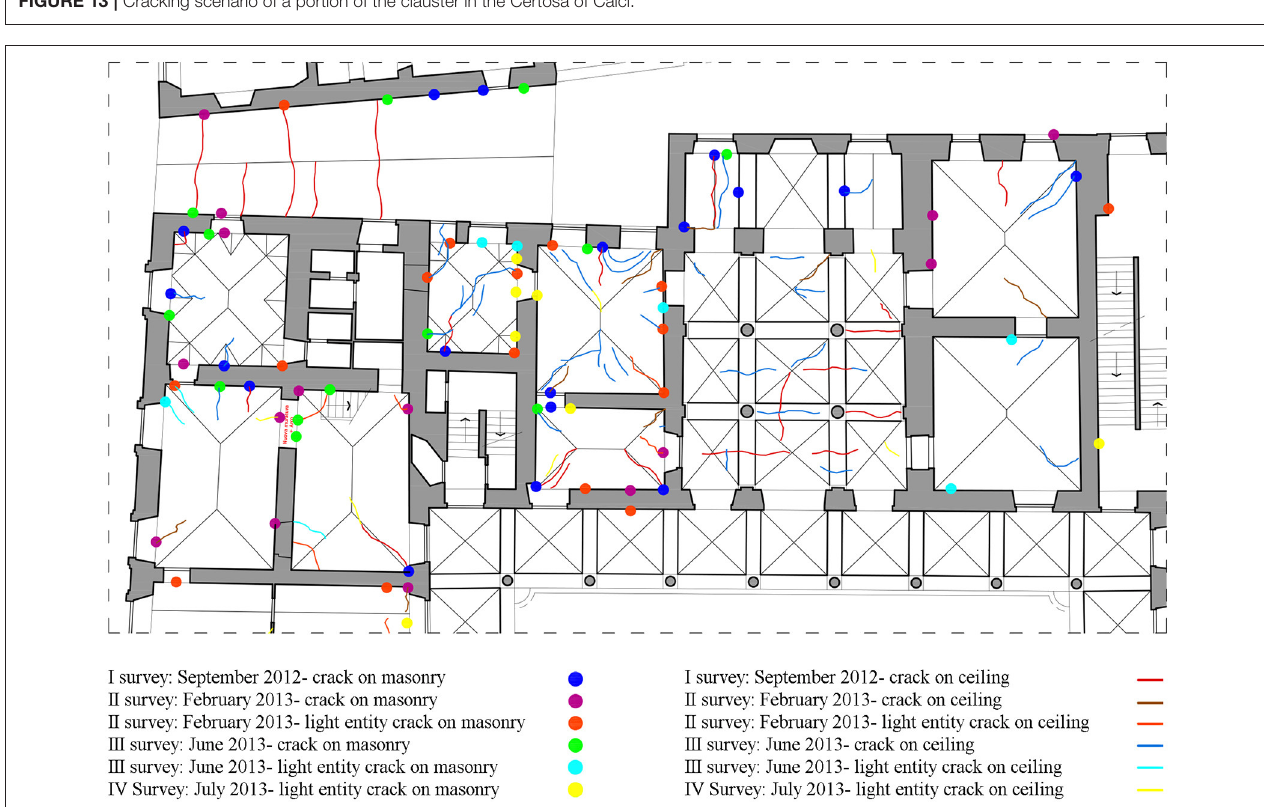
FIGURE 14 | Cracking scenario of a portion of the Palazzo Ducale.